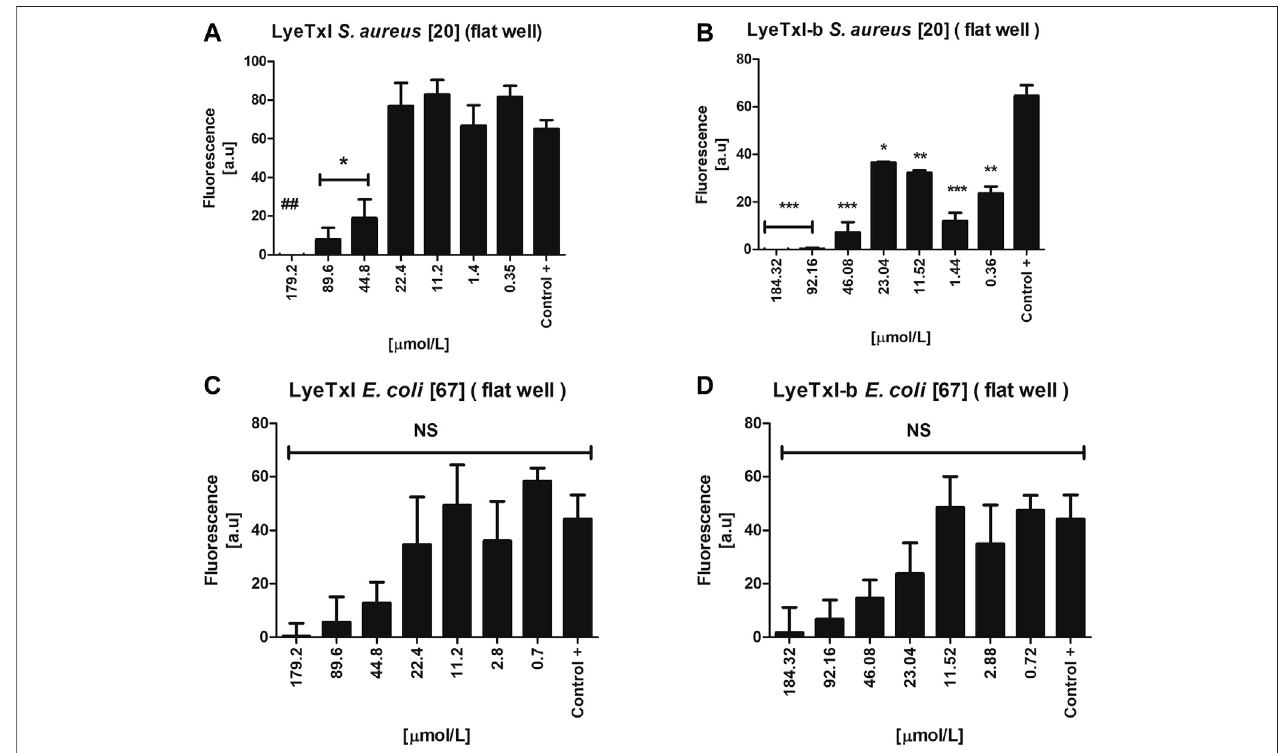
FIGURE 6 | Activity in simple bio fi lm. Bio fi lm environment of isolated S. aureus [20] and E. coli [67] incubated with LyeTxI (A,C) and LyeTxI-b (B,D) at different concentrations of the peptides: 184.32 to 0.36 µmol L − 1 . Data were statistically analyzed by simple variance ANOVA followed by post-test Turkey, with * p < 0.05; ** p < 0.01 *** p < 0.001 in relation to the control. NS (cid:2) not signi fi cant.